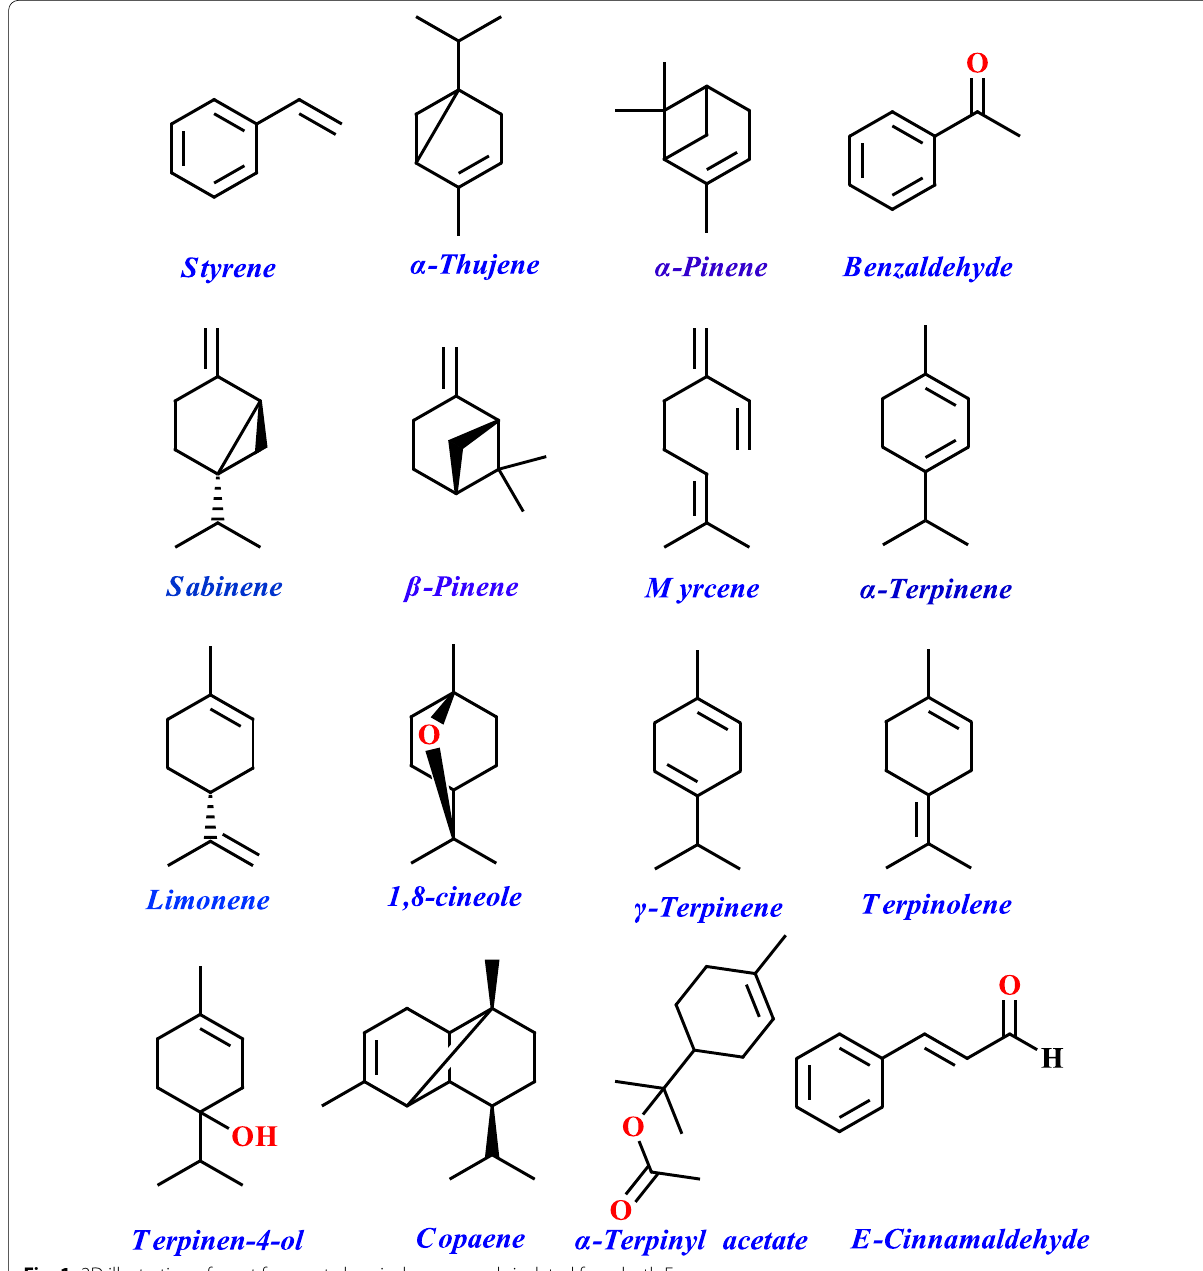
Fig. 1 2D illustration of most frequent chemical compounds isolated from both